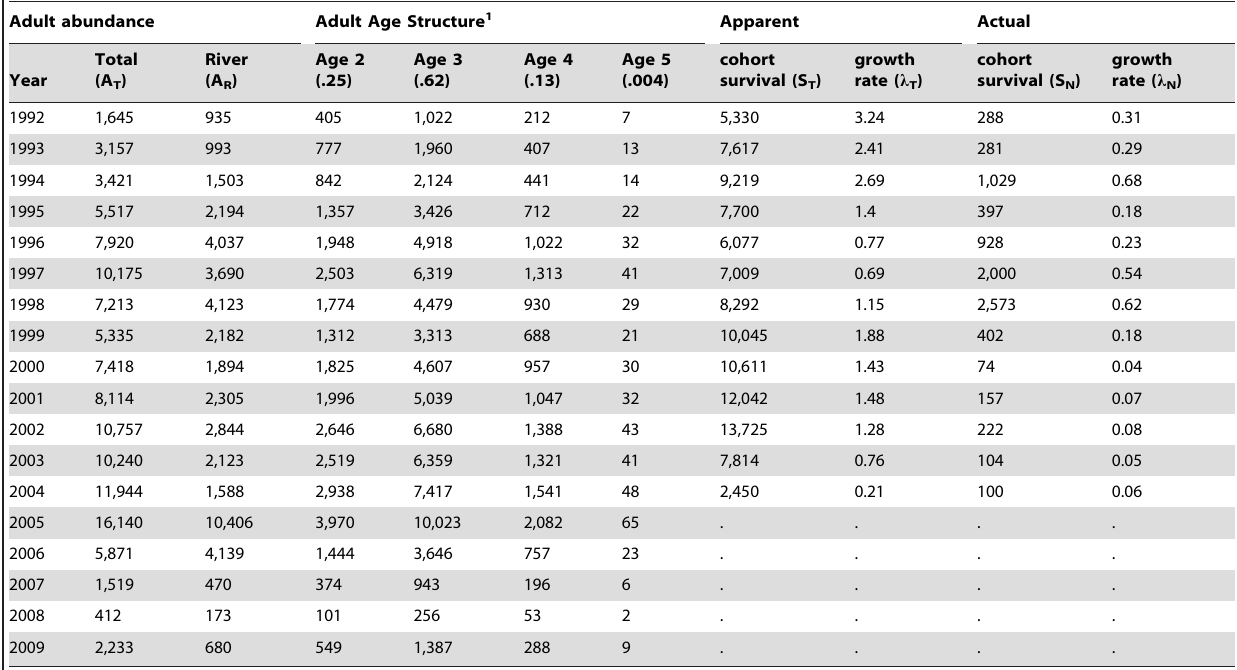
Table 2. Cohort reconstruction and population growth